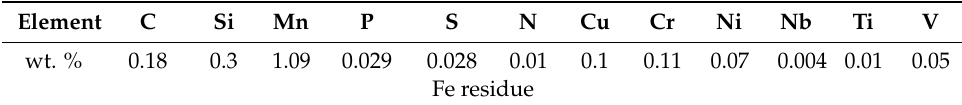
Table 4. Chemical composition of 17G2SF grade steel.